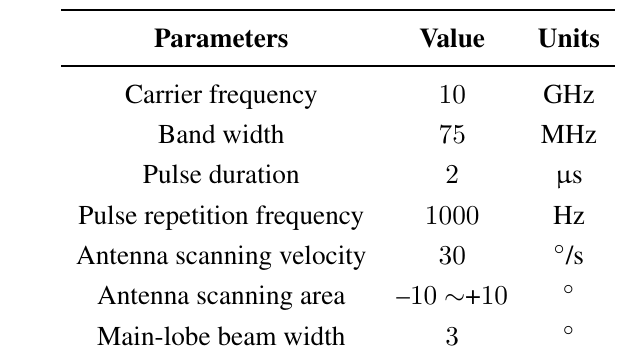
Figure 4. Location of targets in simulated scene. Table 1. Simulation